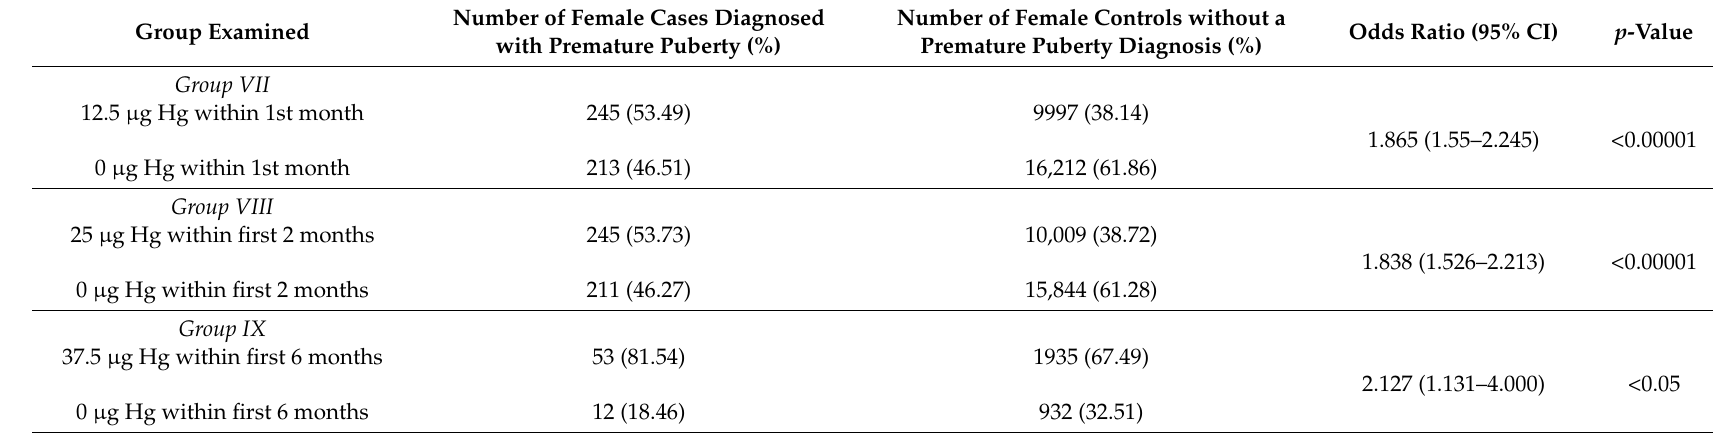
Table 3. This table summarizes the organic Hg exposure from the hepatitis B vaccine preserved with Thimerosal in the female cases with a premature puberty diagnosis compared to the female controls 1 , within the database of the VSD.